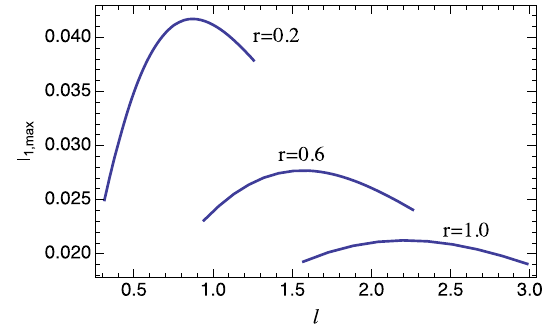
FIG. 5. Plot of the maximum values of I 1 as a function of the dimensionless length l for r ¼ 0 . 2 , 0.6, and 1.0.